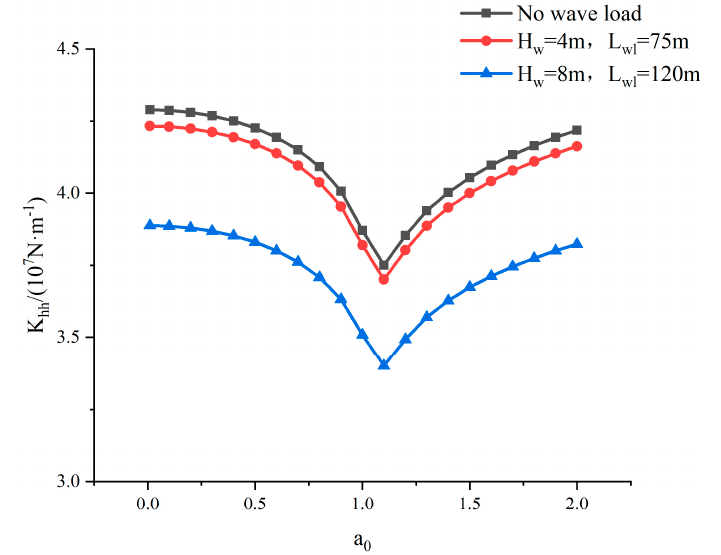
Figure 15. The influence of the pile length in seawater on the foundation impedance.